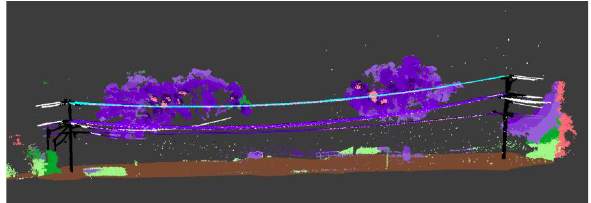
Figure 1. Salt and pepper noise in point cloud data resulting from poor segmentation.